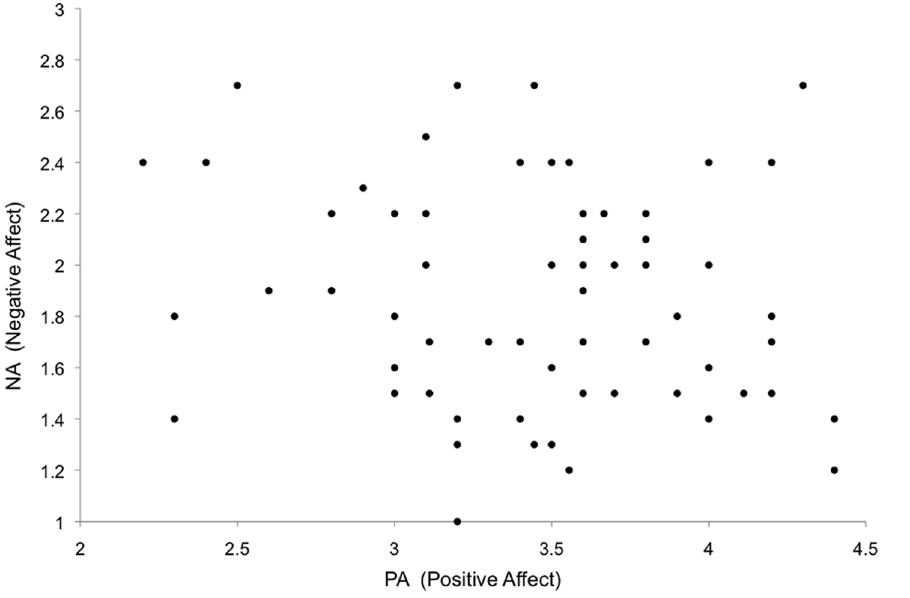
Figure 4. No correlation between the scales. A correlation analysis revealed no correlation between individual scores of NA and PA (r 2 =0.025, p . 0.4), as expected from their construction as orthogonal scales (see Figure